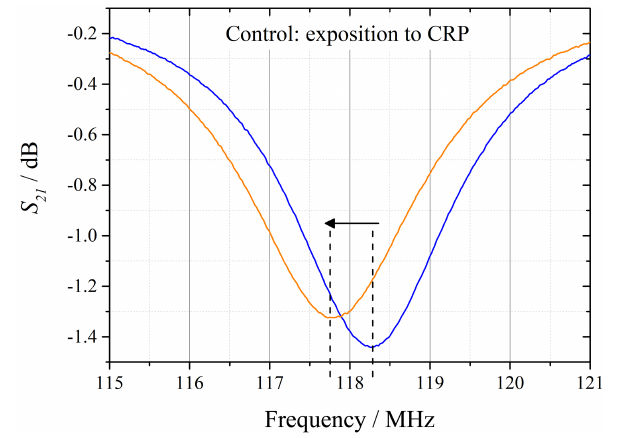
Figure 23. S 21 with deionized water as sample before and after exposition to